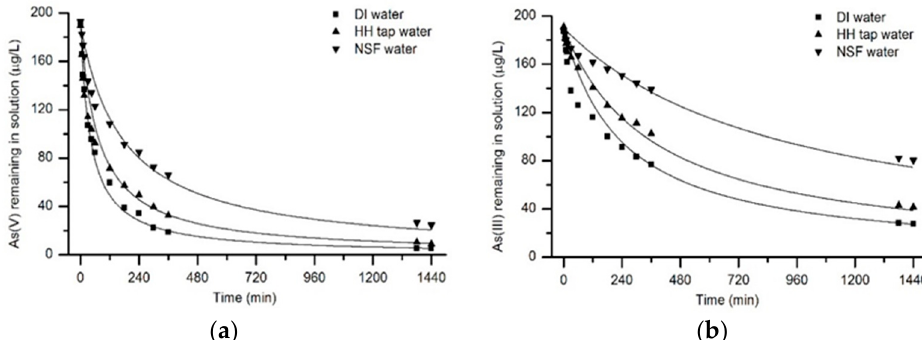
Figure 4. Rate of adsorption of ( a ) As(V) and ( b ) As(III) in different water matrixes at an initial pH of 7.9 and temperature of 20 °C, using an adsorbent dosage of 50 mg/L and an initial (As(V)) 190 µg/ L and initial (As(III)) 190 µg/L.